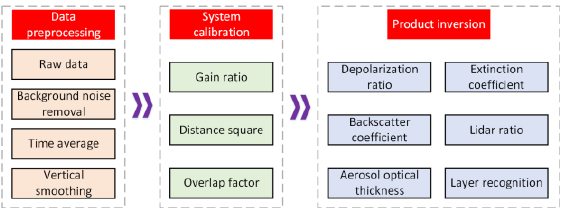
Fig.2 HSRL retrieval algorithm block